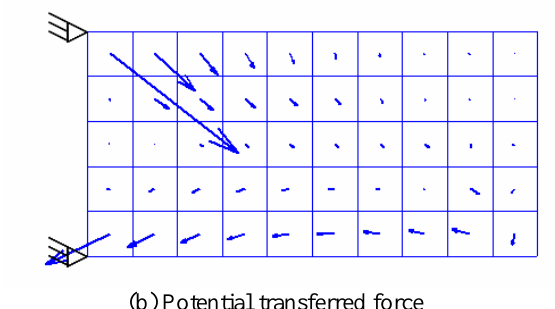
Fig. 8. Transferred and potential transferred force to the reaction points with 50 elements